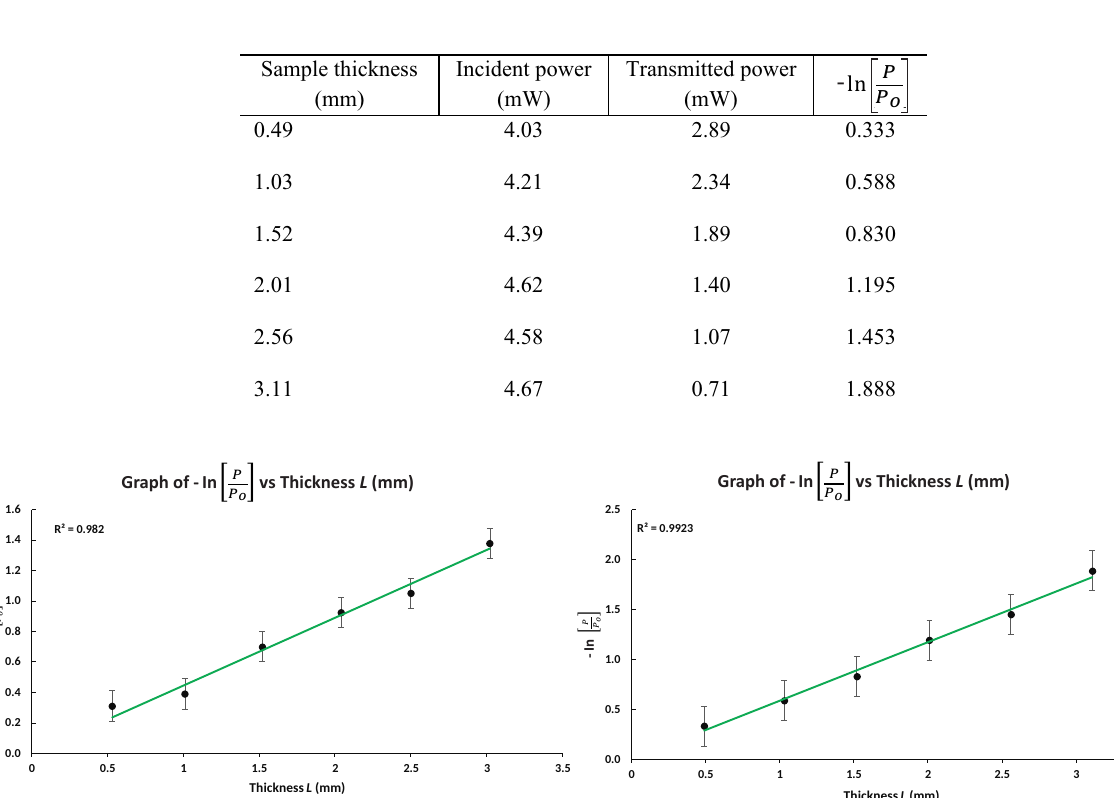
Fig. 3 . Logarithmic intensity as a function of thickness with associated linear fit options to determine the total attenuation coefficient for the slime phantom with absorbers at 630